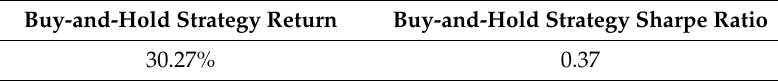
Table 4. Performance of the buy-and-hold strategy.